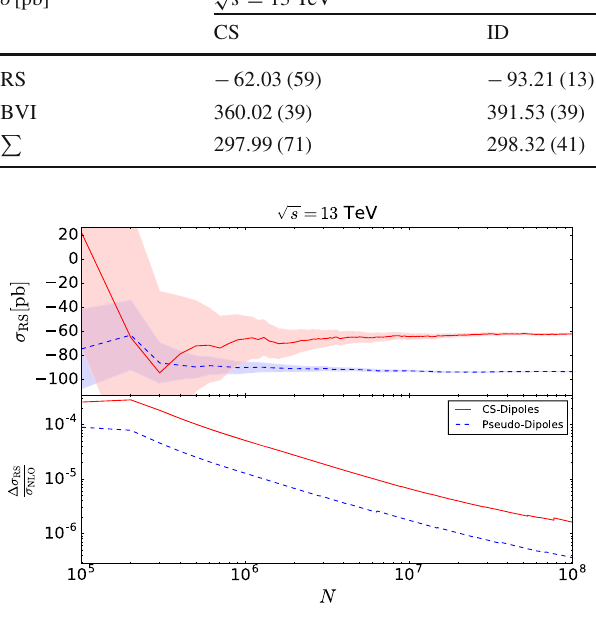
Fig. 12 Evolution of the Monte-Carlo integration results for the sub- tracted real-emission contribution to the total cross section in pp → √ W + W − j b j b at s = 13 TeV over number of sampled phase-space points N . Red solid lines show results from standard CS-dipoles, while blue dashed lines correspond to pseudo-dipoles. The colored bands in the upper panels and the lines in the lower panels show the one σ sta- tistical uncertainty of the Monte-Carlo